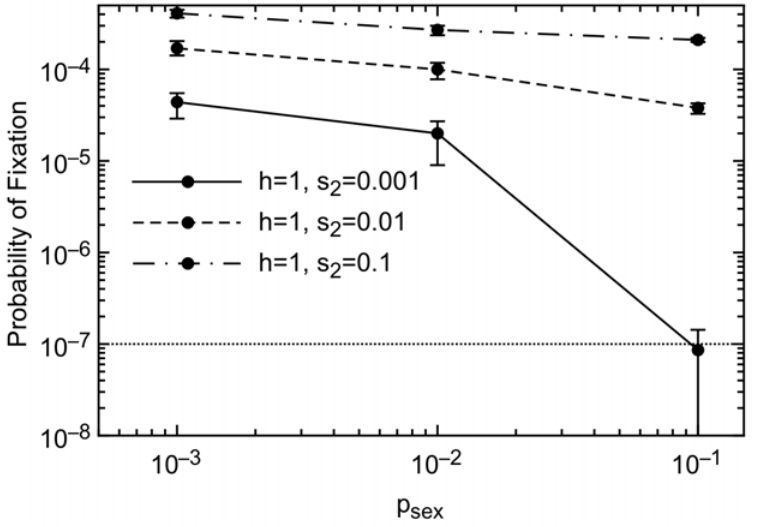
Figure 7. Fixation probabilities starting from a single copy. prf + fixes more often than the neutral expectation (10 2 7 ), except when selection is weak ( s 2 # 0.001) and sex is common p sex $ 0.1. All parameters are equal to values in Figure 3, with the additional parameter m prf + equal to 10 2 9 . For p sex =0.001 and p sex =0.01, results are based on 10 6 replicates. For p sex =0.1 and s 2 =0.001, the number of replicates is 3.5 6 10 7 . Otherwise the number of replicates is 6 6 10 6 .